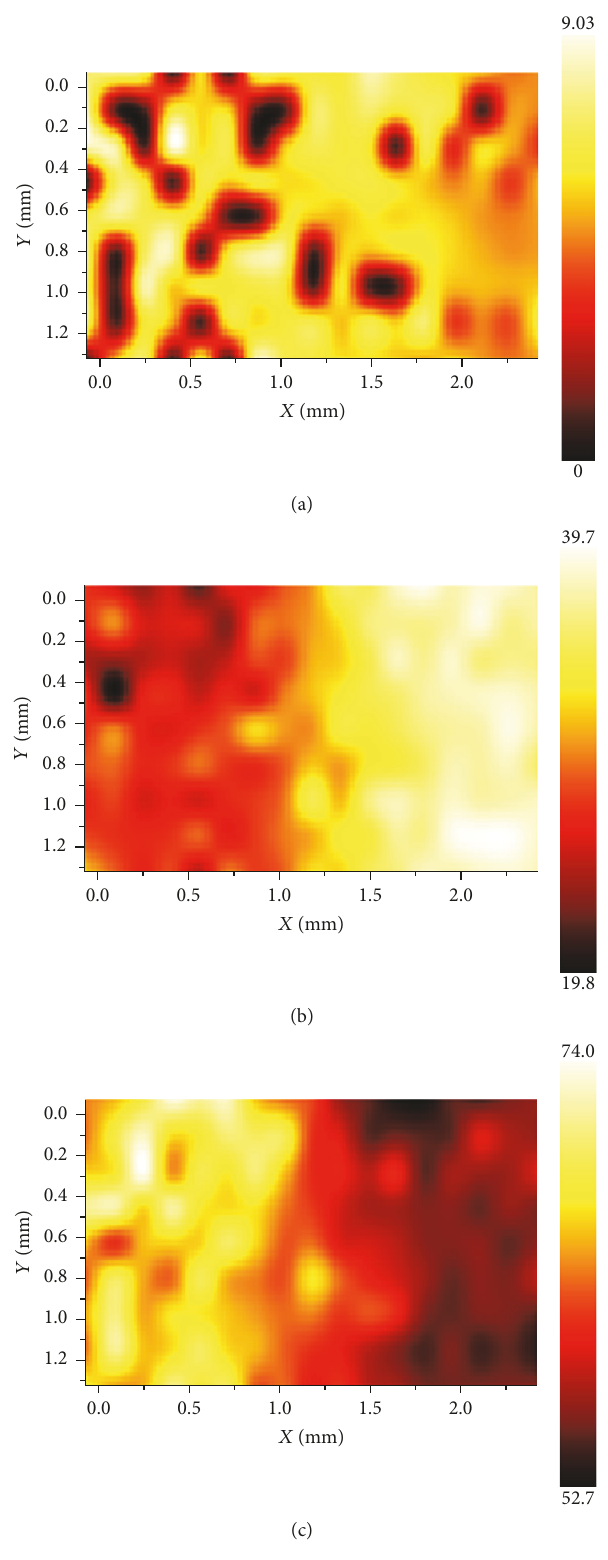
Figure 12: XPS maps for the atomic percentages of (a) Al2p; (b) O1s; and (c) Mg1s for the as-received AZ91D